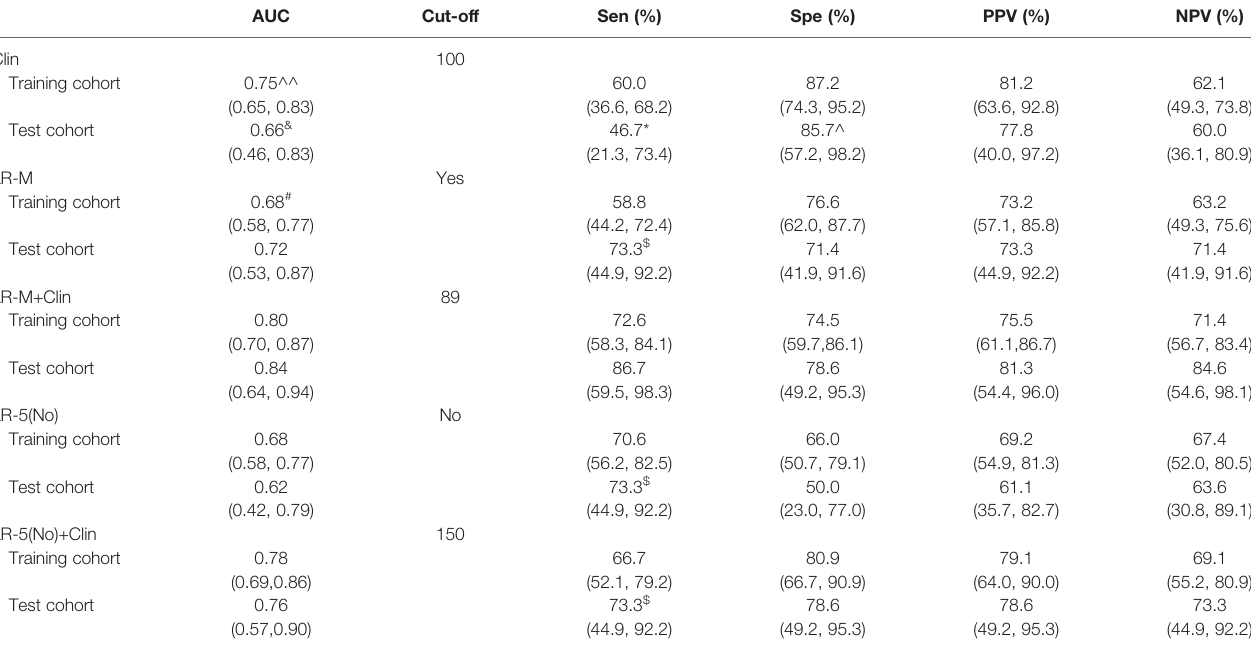
TABLE 3 | Diagnostic performance of different models for predicting MVI in training and test cohort.